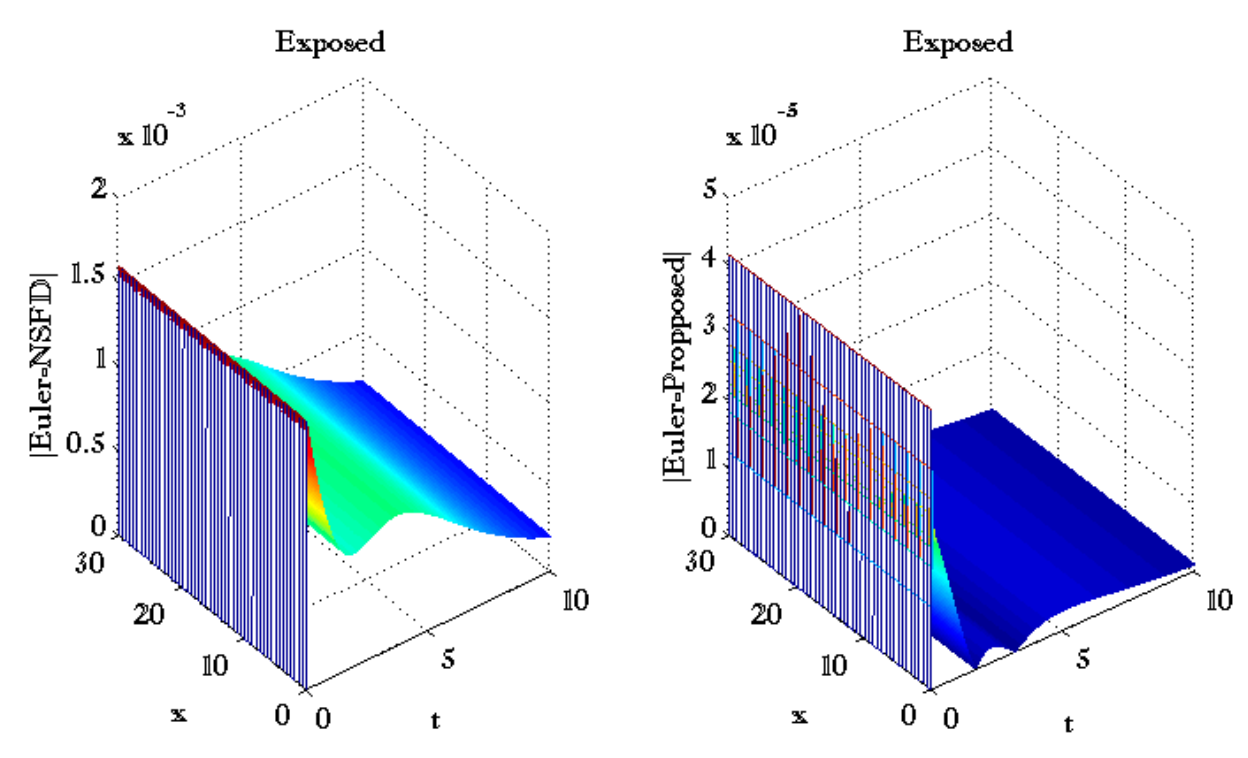
Figure 5. Three-dimensional comparisons of proposed and NSFD schemes for exposed individuals using N x = 50, N t = 1300, α 1 = 0.1, β = 0.1, γ = 0.3, σ = 0.4, µ = 0.5, d 1 = 2, d 2 = 2.5, d 3 = 2.5, d 4 = 2, d 5 = 2, α = 0.9.